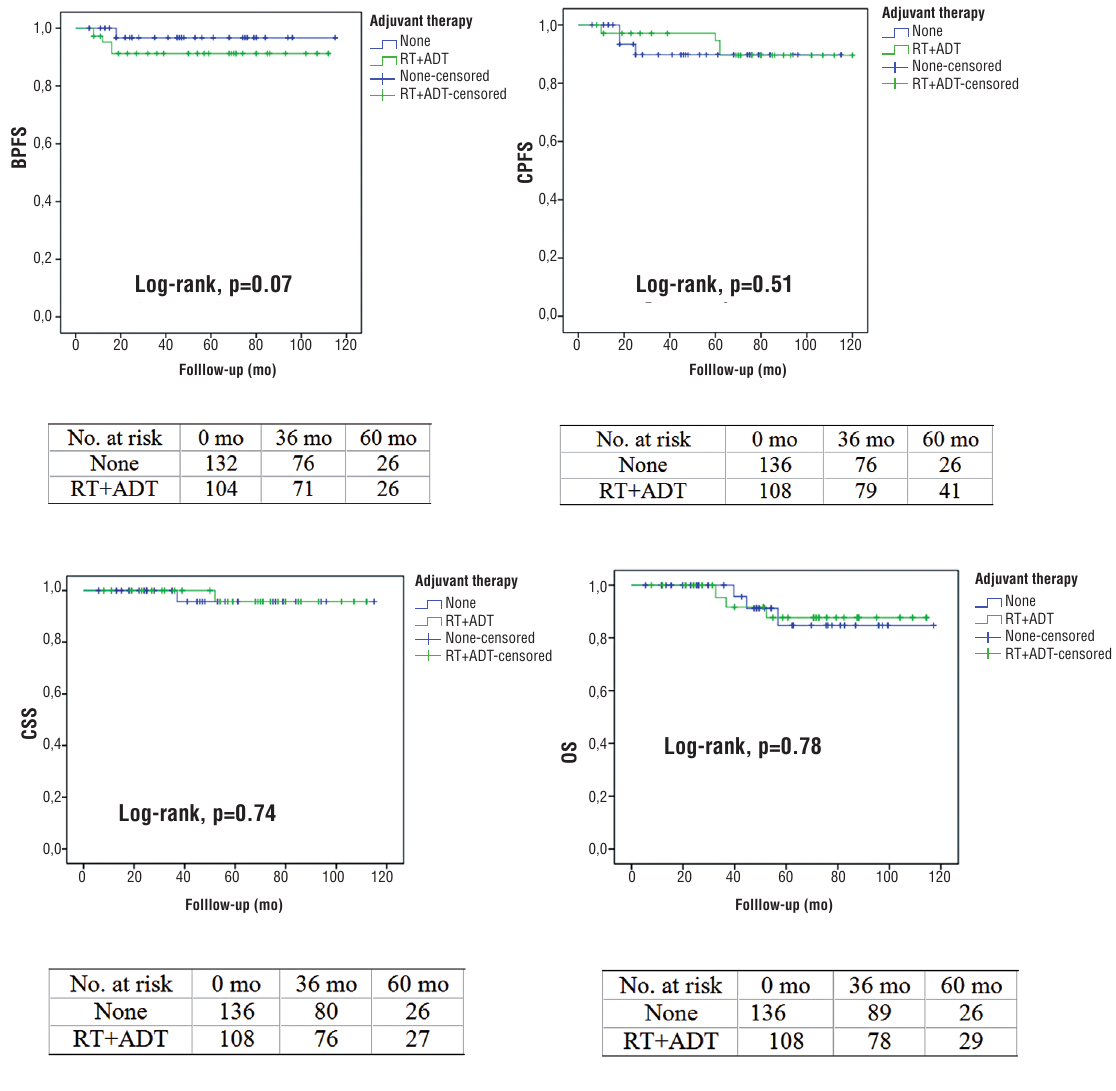
Figure 1 - Kaplan-Meier curve analysis of BFPS, CPFS, PCSS and OS between groups. Adjuvant therapy